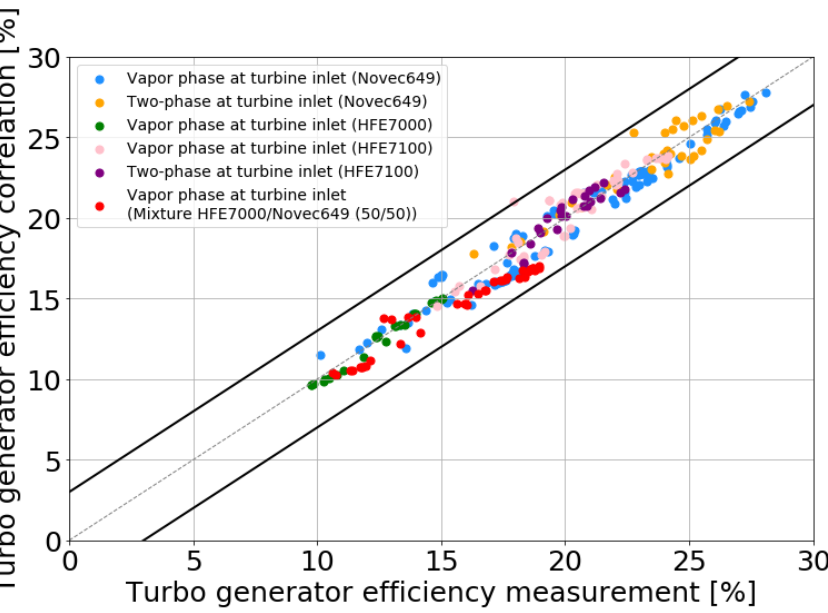
Figure 16. Turbo-generator efficiency correlation based on turbo-generator efficiency measurement (single and two phase).